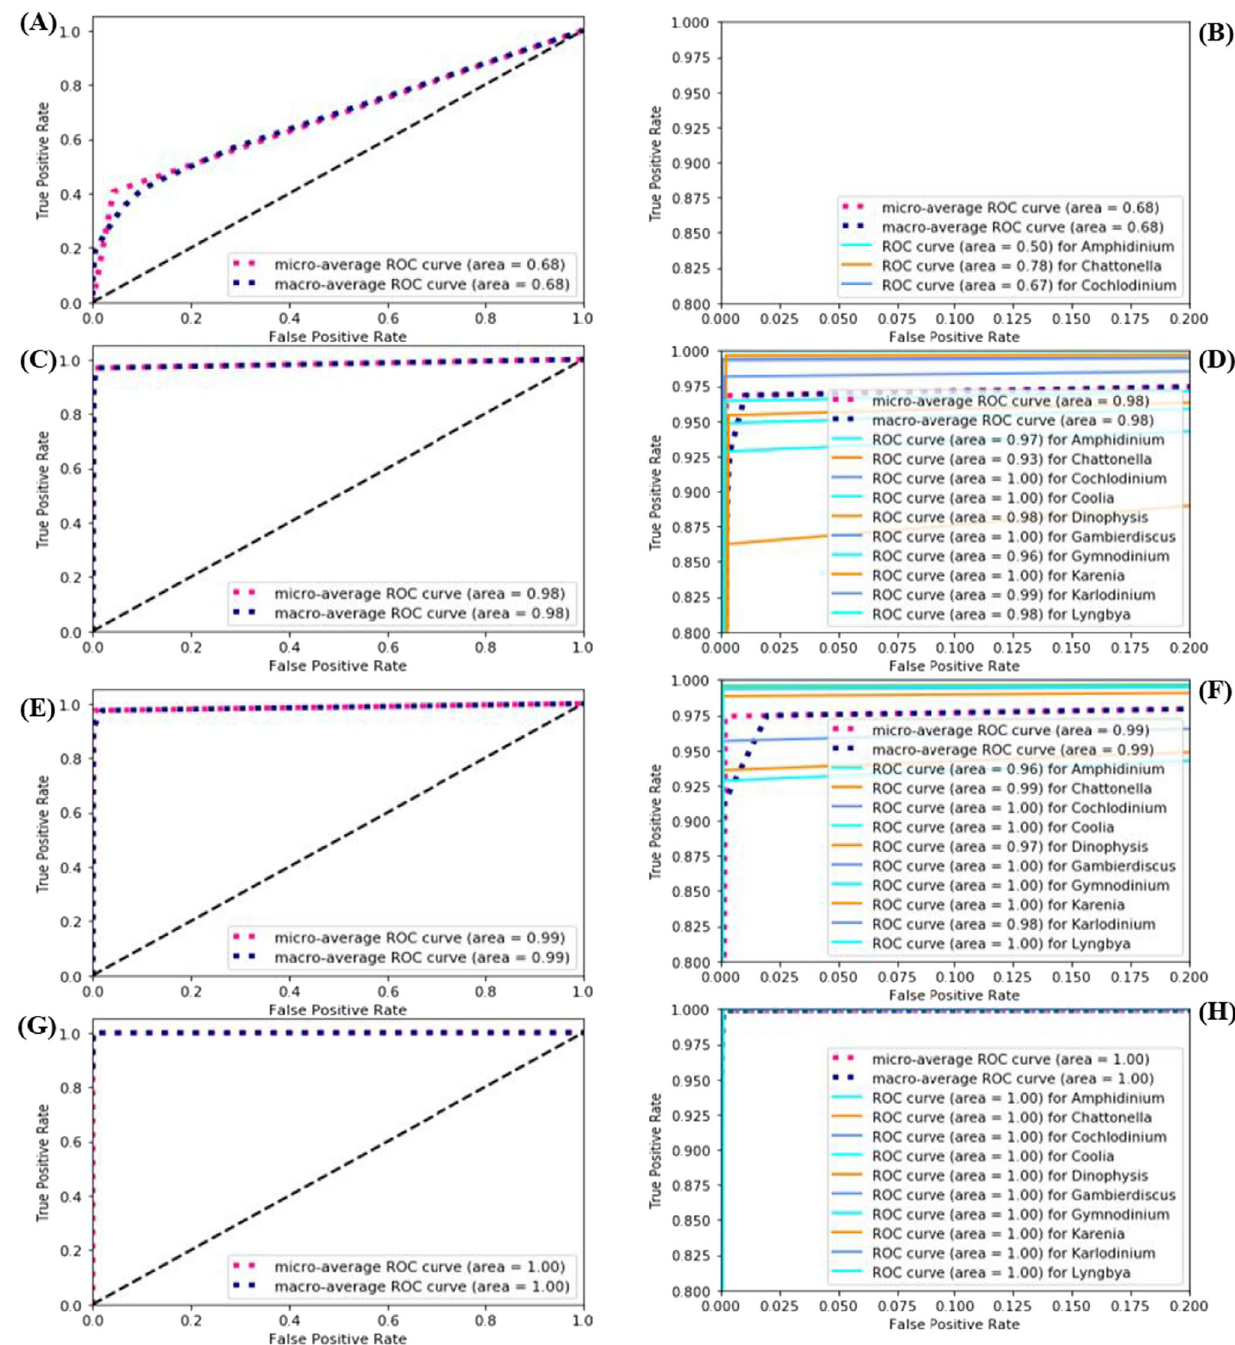
Fig. 4 The ROC curves of the proposed models and class-wise ROC curve area for studied CNN models. MobileNetV-2 ( A and B ), VGG16 ( C and D ), AlexNet ( E and F ), and modified ResNeXt ( G and H